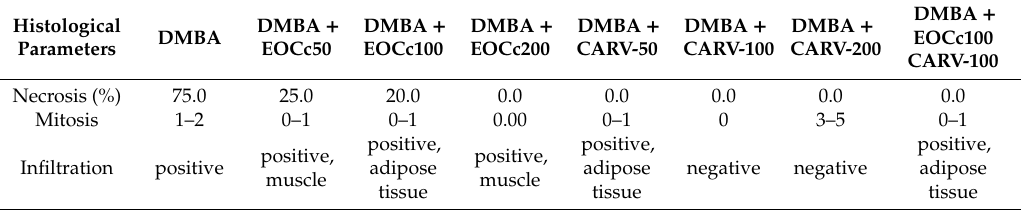
Table3. E ff ectoftheessentialoilof C.citratus andcarvacrolonhistologicalparametersinDMBA-induced Table 3. Effect of the essential oil of C. citratus and carvacrol on histological parameters in DMBA- breast carcinogenesis in induced breast carcinogenesis in rats.